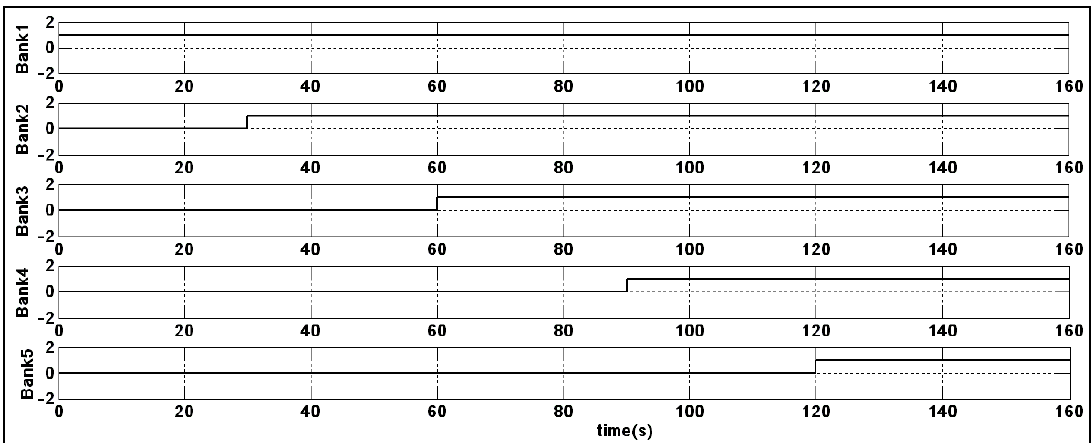
Figure 9. Speed tracking and load voltage under the adaptive SMC system with unmodeled quantity (friction).